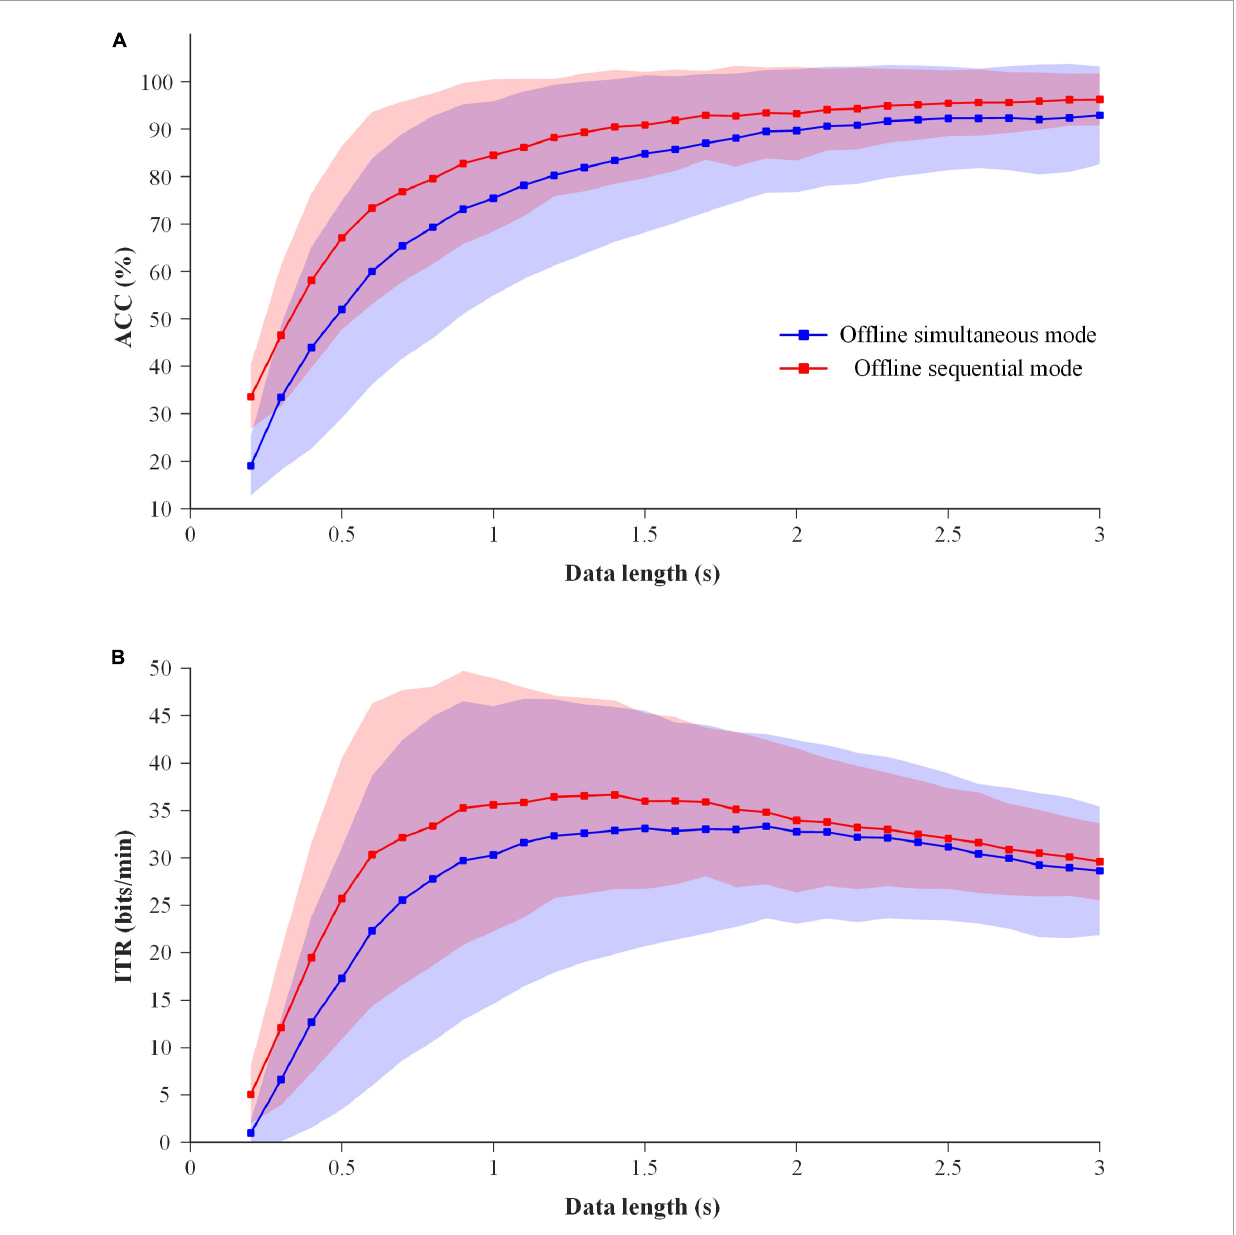
FIGURE9 Comparison of EEG classification performance between offline simultaneous and sequential modes at data length of 0.2–3 s. (A) ACC. (B)